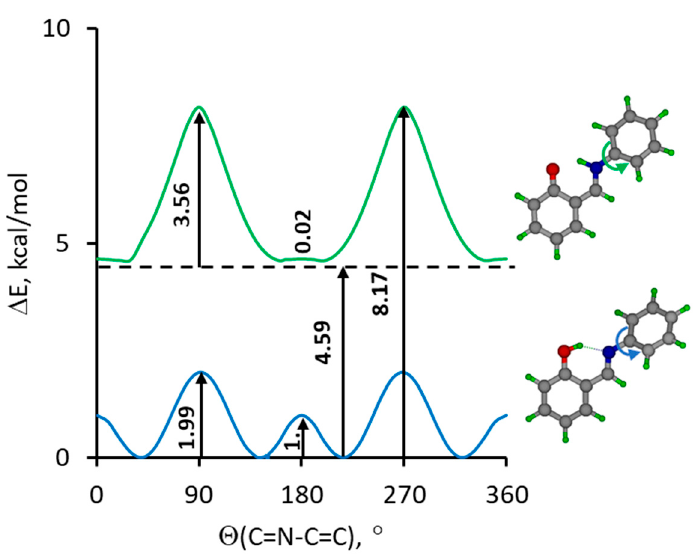
Figure 7. The calculated potential energy profile (B3LYP/6-311++G(d,p)) for a gradual rotation around the N-C bond for enol-imine (blue line) and keto-amine (green line) forms of studied Schiff base.